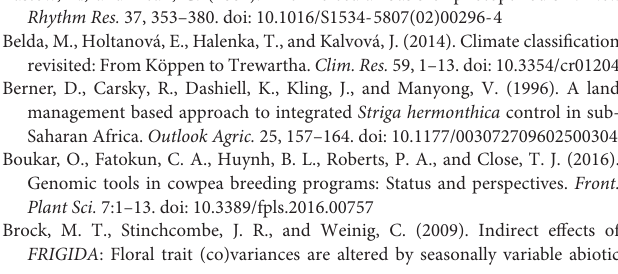
Supplementary Figure 1 | Daily maximum (MaxT) and minimum (MinT) temperature and photoperiod (orange line) in Ft. Collins, CO during the trial in 2019. Supplementary Figure 2 | Daily maximum (MaxT) and minimum (MinT) temperature and photoperiod (orange line) in Ft. Collins, CO during the trial in 2020. Supplementary Figure 3 | Daily maximum (MaxT) and minimum (MinT) temperature and photoperiod (orange line) in Citra, FL during the trial in 2018. Supplementary Figure 4 | Manhattan plots from the GWAS analysis pertaining to 368 accessions of the cowpea mini-core collection planted in 2019 in Colorado. Left panel: Negative log 10 -transformed p -values for each SNP ( y axis) are plotted against the chromosomal position ( y axis). The red line represents Bonferroni-corrected threshold of 0.05 for genome-wide statistically significant associations and the blue line shows suggestive associations ( p = 1 × 10 − 5 ). Right panel shows the QQ plots where x -axis is expected negative log p -values and the y -axis is observed negative log p -values. GWAS results for days to flowering using (A) BLINK; (B) FarmCPU; (C) GLM; and (D) MLM. Supplementary Figure 5 | Manhattan plots from the GWAS analysis pertaining to 368 accessions of the cowpea mini-core collection planted in 2020 in Colorado. Left panel: Negative log 10 -transformed p -values for each SNP ( y axis) are plotted against the chromosomal position ( y axis). The red line represents Bonferroni-corrected threshold of 0.05 for genome-wide statistically significant associations and the blue line shows suggestive associations ( p = 1 × 10 − 5 ). Right panel shows the QQ plots where x -axis is expected negative log p -values and the y -axis is observed negative log p -values. GWAS results for days to flowering using (A) BLINK; (B) FarmCPU; (C) GLM; and (D) MLM. Supplementary Figure 6 | Manhattan plots from the GWAS analysis pertaining to 292 accessions of the cowpea mini-core collection planted in 2018 in Florida. Left panel: Negative log 10 -transformed p -values for each SNP ( y axis) are plotted against the chromosomal position ( y axis). The red line represents Bonferroni-corrected threshold of 0.05 for genome-wide statistically significant associations and the blue line shows suggestive associations ( p = 1 × 10 − 5 ). Right panel shows the QQ plots where x -axis is expected negative log p -values and the y -axis is observed negative log p -values. GWAS results for days to flowering using (A) BLINK; (B) FarmCPU; (C) GLM; and (D) MLM. Supplementary Figure 7 | Linkage disequilibrium (LD) decay plot of the 368 accessions of the UCR mini-core collection. Supplementary Table 1 | Information on the 368 accessions in the UCR Minicore. Geographic information have been added whenever available. Supplementary Table 2 | Information on the 292 accessions evaluated in Florida. Geographic information have been added whenever